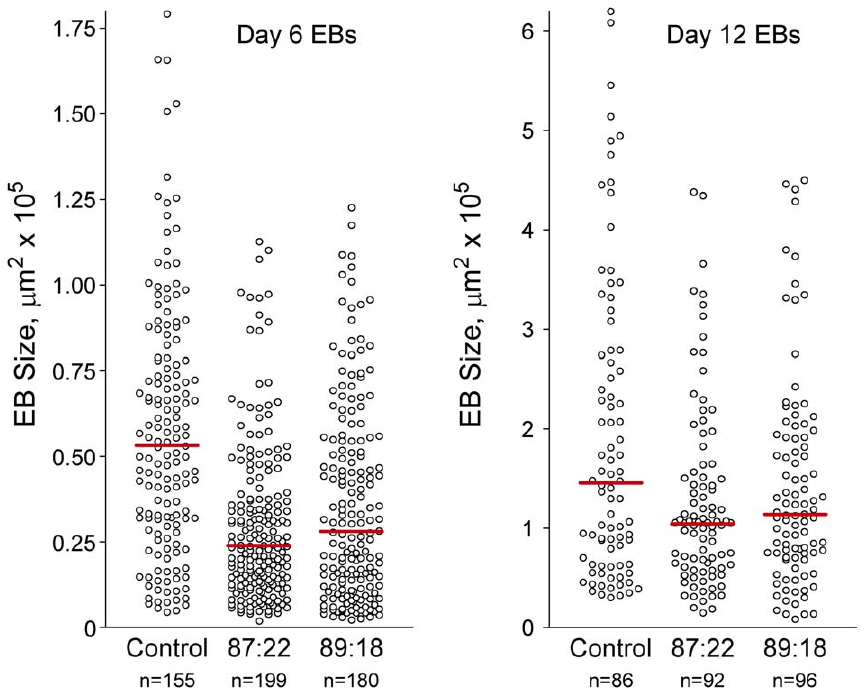
Figure 5. Tim knockdown EBs are smaller and of more uniform size. EBs were grown from control and Tim knockdown ES cell lines Lenti:87- 22 and Lenti:89-18 for 6 and 12 days. EBs were fixed, DAPI-stained and imaged with an Olympus F500 confocal microscope. The EB sizes were then estimated by determining the EB surface area from the images using the ImageJ 1.43U software suite. Scattergrams of the resulting data were analyzed using the Kruskal-Wallis test (nonparametric unpaired analysis of variance by ranks; Prizm Software, GraphPad, Inc.) and a significant difference in the median EB size was observed across both groups (P , 0.0001). The median EB size is shown in each group by the red bar.